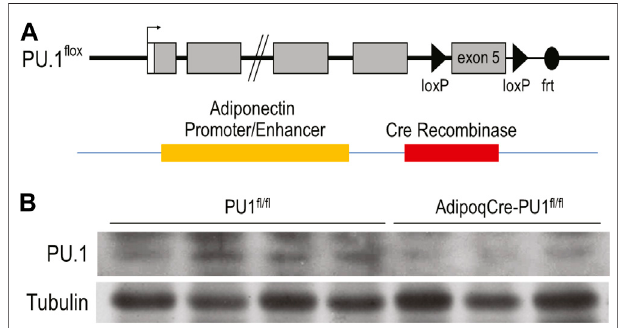
FIGURE 1 | Generation of Adipocyte-Speci fi c PU.1 KO Mice. (A) The schematic diagram of AdipoqCre-PU.1 fl / fl Mice. Mice that have the PU.1 gene exon 5 fl anked with loxP sequences were breed with mice carrying a transgene containing Cre recombinase under the control of Adiponectin gene promoter and enhancer. (B) The expression of PU.1 in isolated adipocytes was detected using anti-PU.1 Western blot analysis.